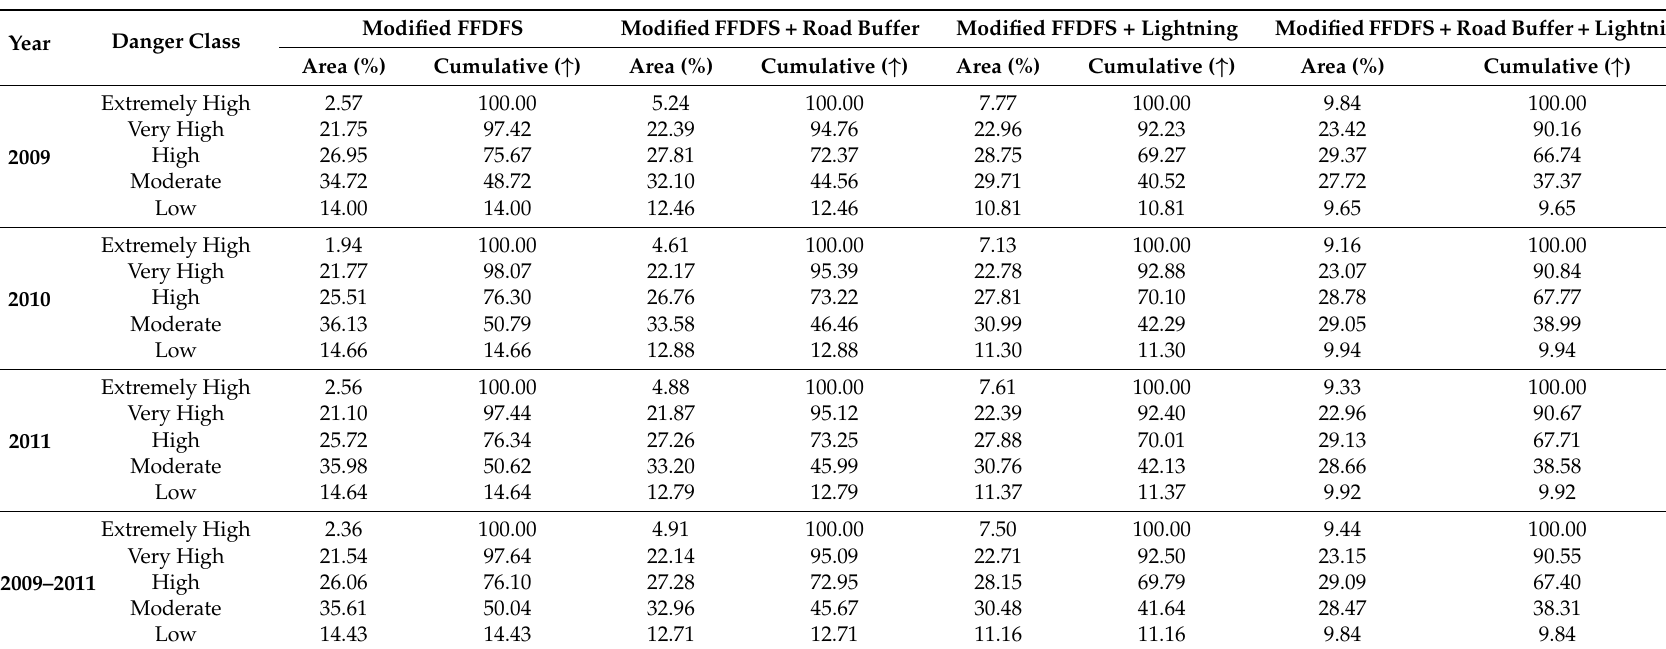
Table 3. Comparison of the modified FFDFS and its integration with road buffers and lightning-caused SFD maps against the ground-based forest fire spots in terms of areas under the fire danger classes *